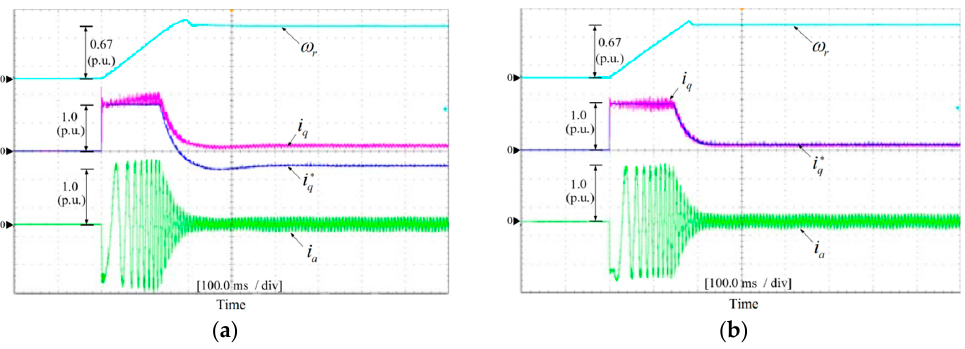
Figure 9. Experimental results of motor starting with mismatched resistance: ( a ) TBC; ( b ) AIBC_FP.